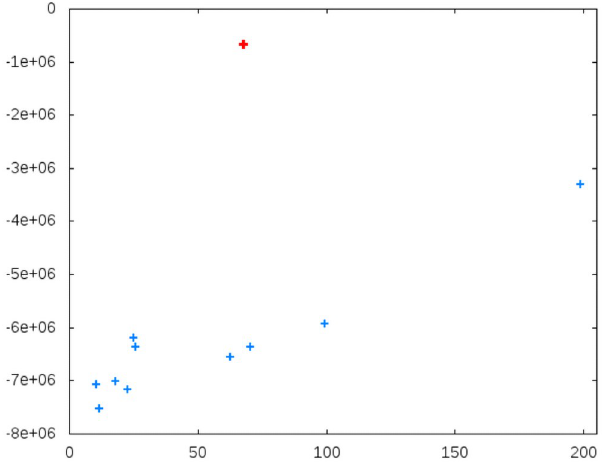
Fig 8. Calculated (y-axis) versus laboratory values (x-axis) for bilirubin of an independent set of 11 patients. The serum sample of the outlier, highlighted in red, contained a visible residuum.